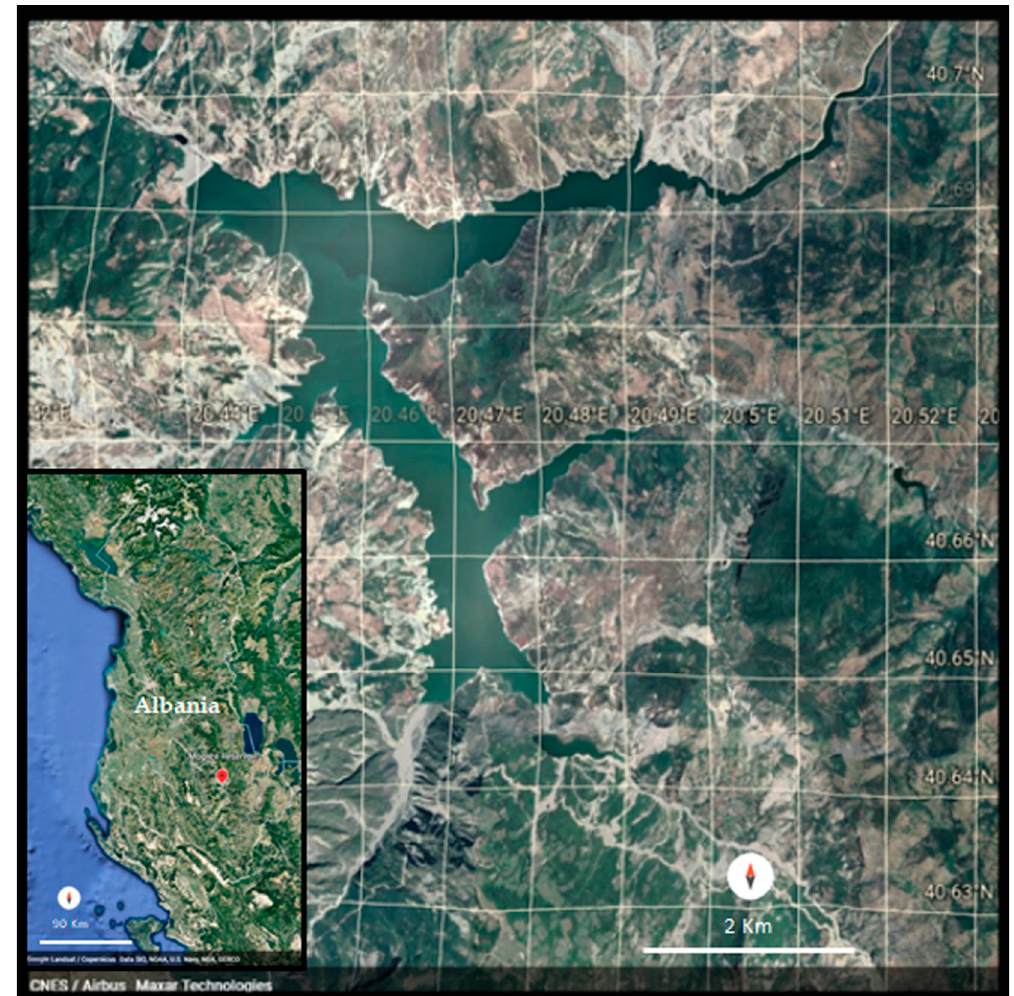
Figure 1. Map of the Moglicë Reservoir in Albania.